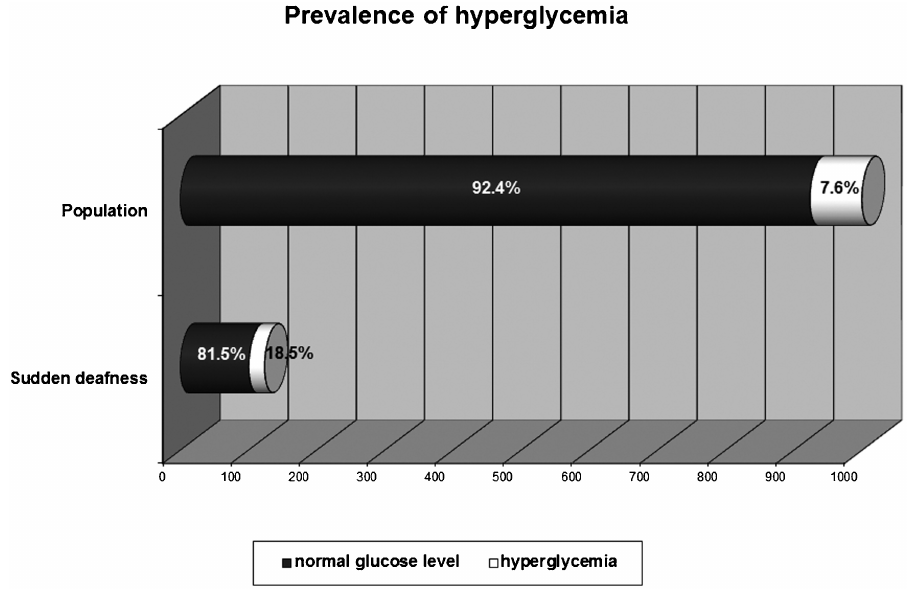
Figure 1 - Prevalence of hyperglycemia in patients with sudden deafness and in the general